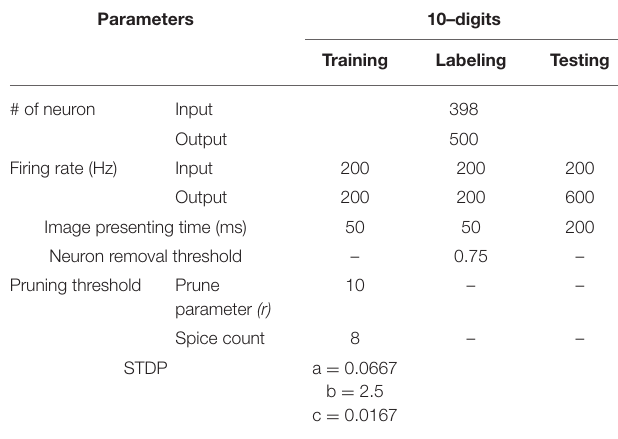
TABLE 1 | Simulation parameters used in training, labeling and testing for this